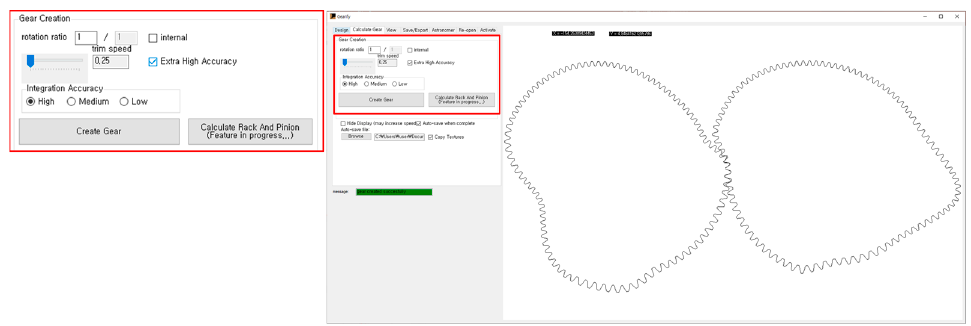
Figure 9. Insertion of design information for driving gear.